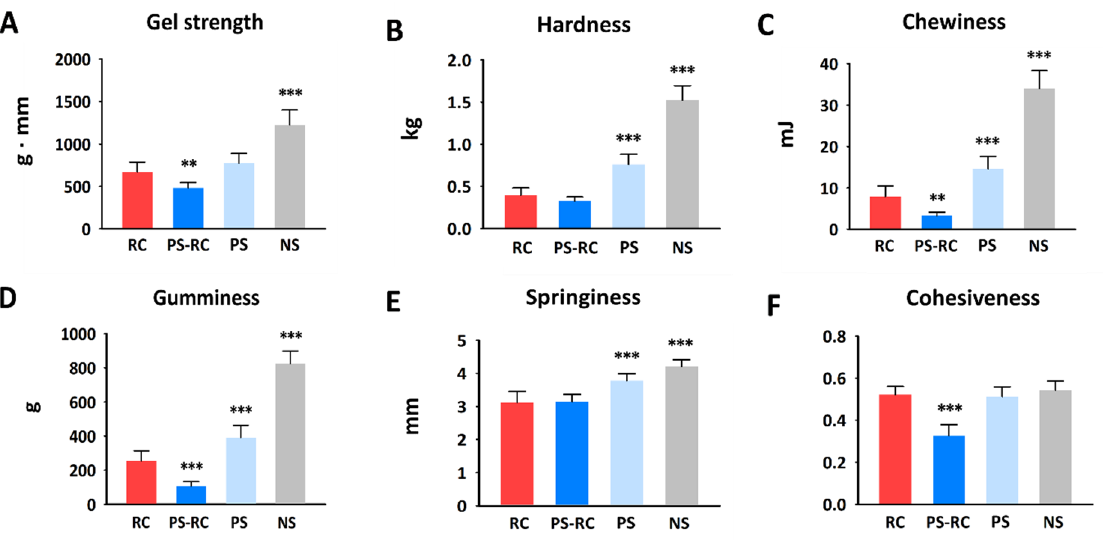
Figure 2. Gel strength ( A ) and texture profiles ( B – F ) of real snow crab ( C. opilio ) leg meat (RC) and commercial imitation crab sticks (ICSs). Each column represents mean ± SD ( n = 10). Difference from RC: ** = p < 0.01, *** = p < 0.001 (Dunnett’s test). PS-RC, premium ICS with real red snow crab ( C. japonicus ) leg meat; PS, premium ICS without real red snow crab leg meat; NS, normal ICS.